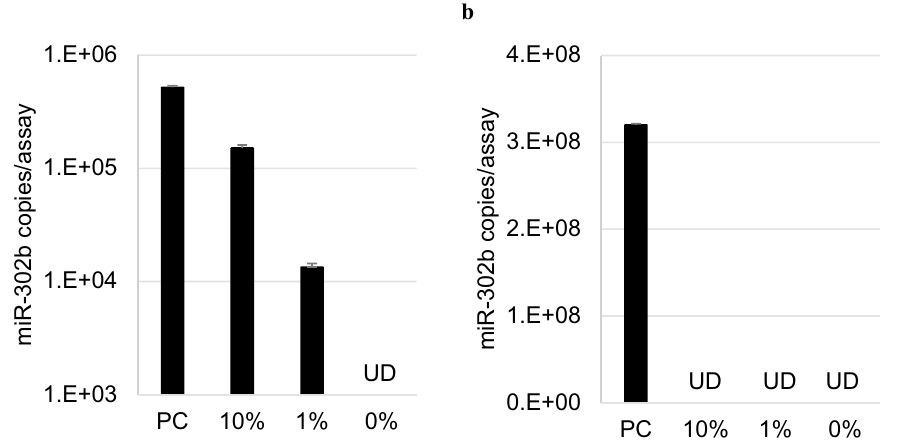
Figure 7. Measuring miR-302b in the culture supernatant allows the detection of iPSCs in a large number of cells. ( a ) 10 7 HCT116 cells were spiked with iPSCs, and miR-302b was measured in the culture supernatant. ( b ) 10 7 HCT116 cells were spiked with iPSCs and miR-302b was measured in the cells. PC: positive control, which is the culture condition of only 10 6 iPS cells. UD: no miRNA detected. Error bar = +